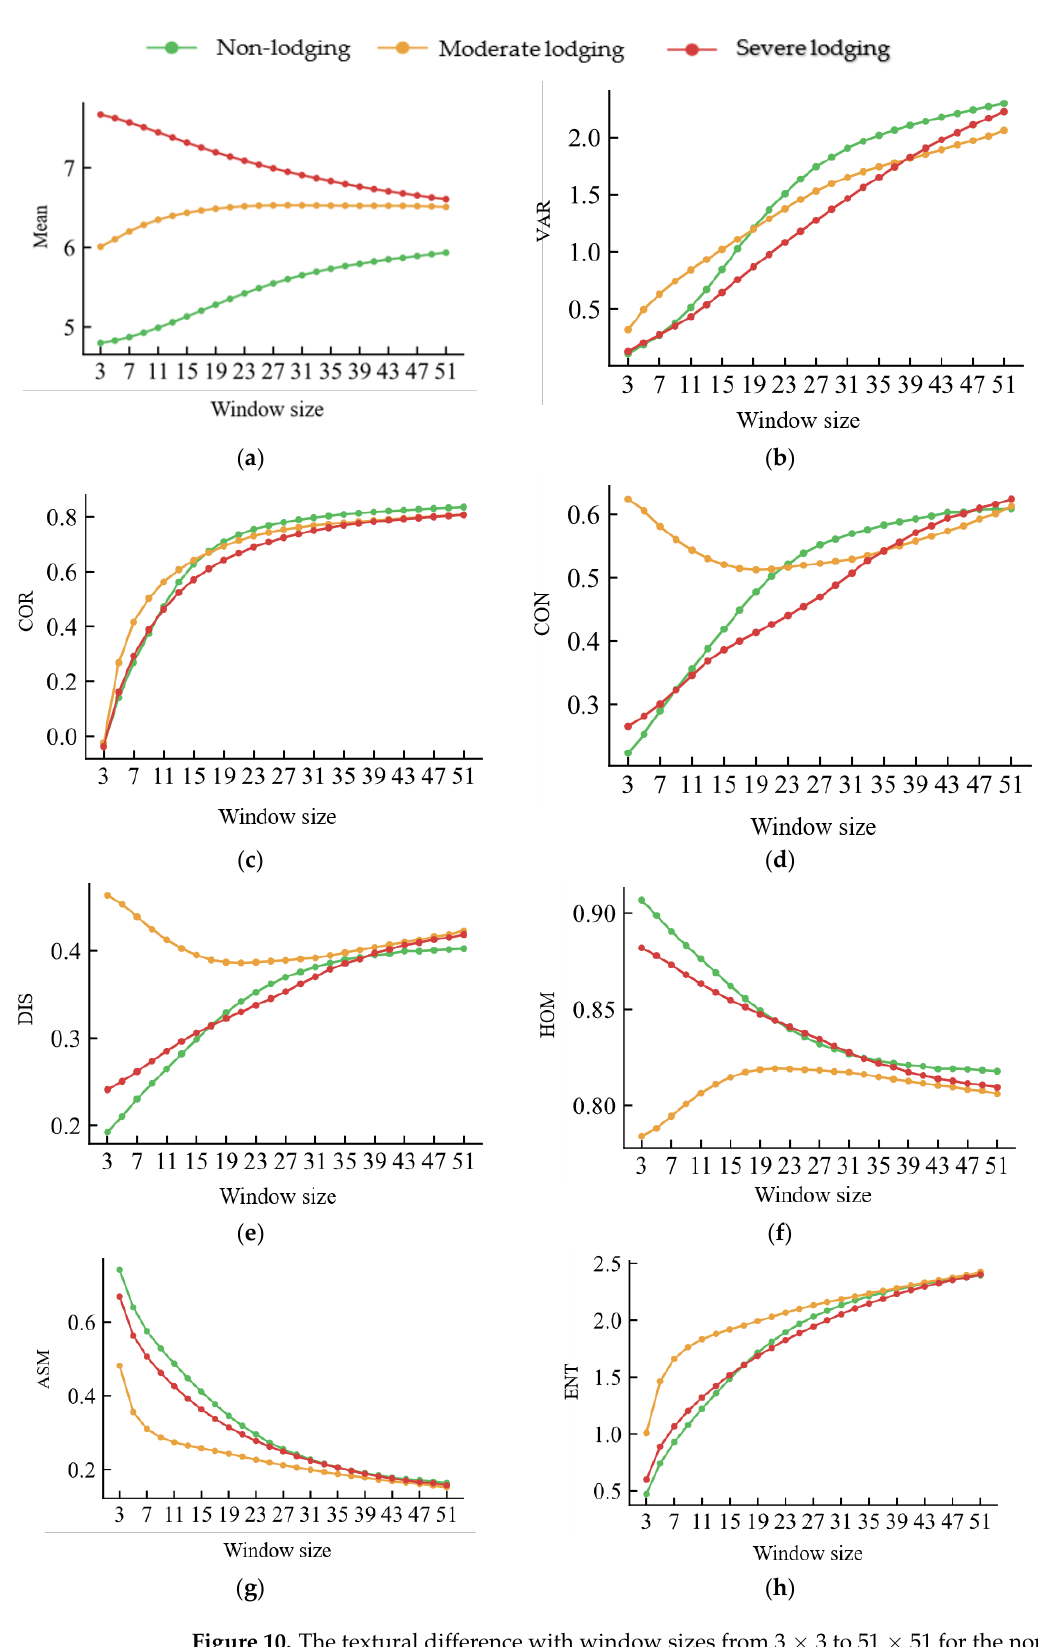
Figure 10. The textural difference with window sizes from 3 × 3 to 51 × 51 for the non-lodged area, moderately lodged area, and severely lodged area. And ( a – h ) represent the textural features of mean, variance, correlation, contrast, dissimilarity, homogeneity, angular second moment, and entropy,